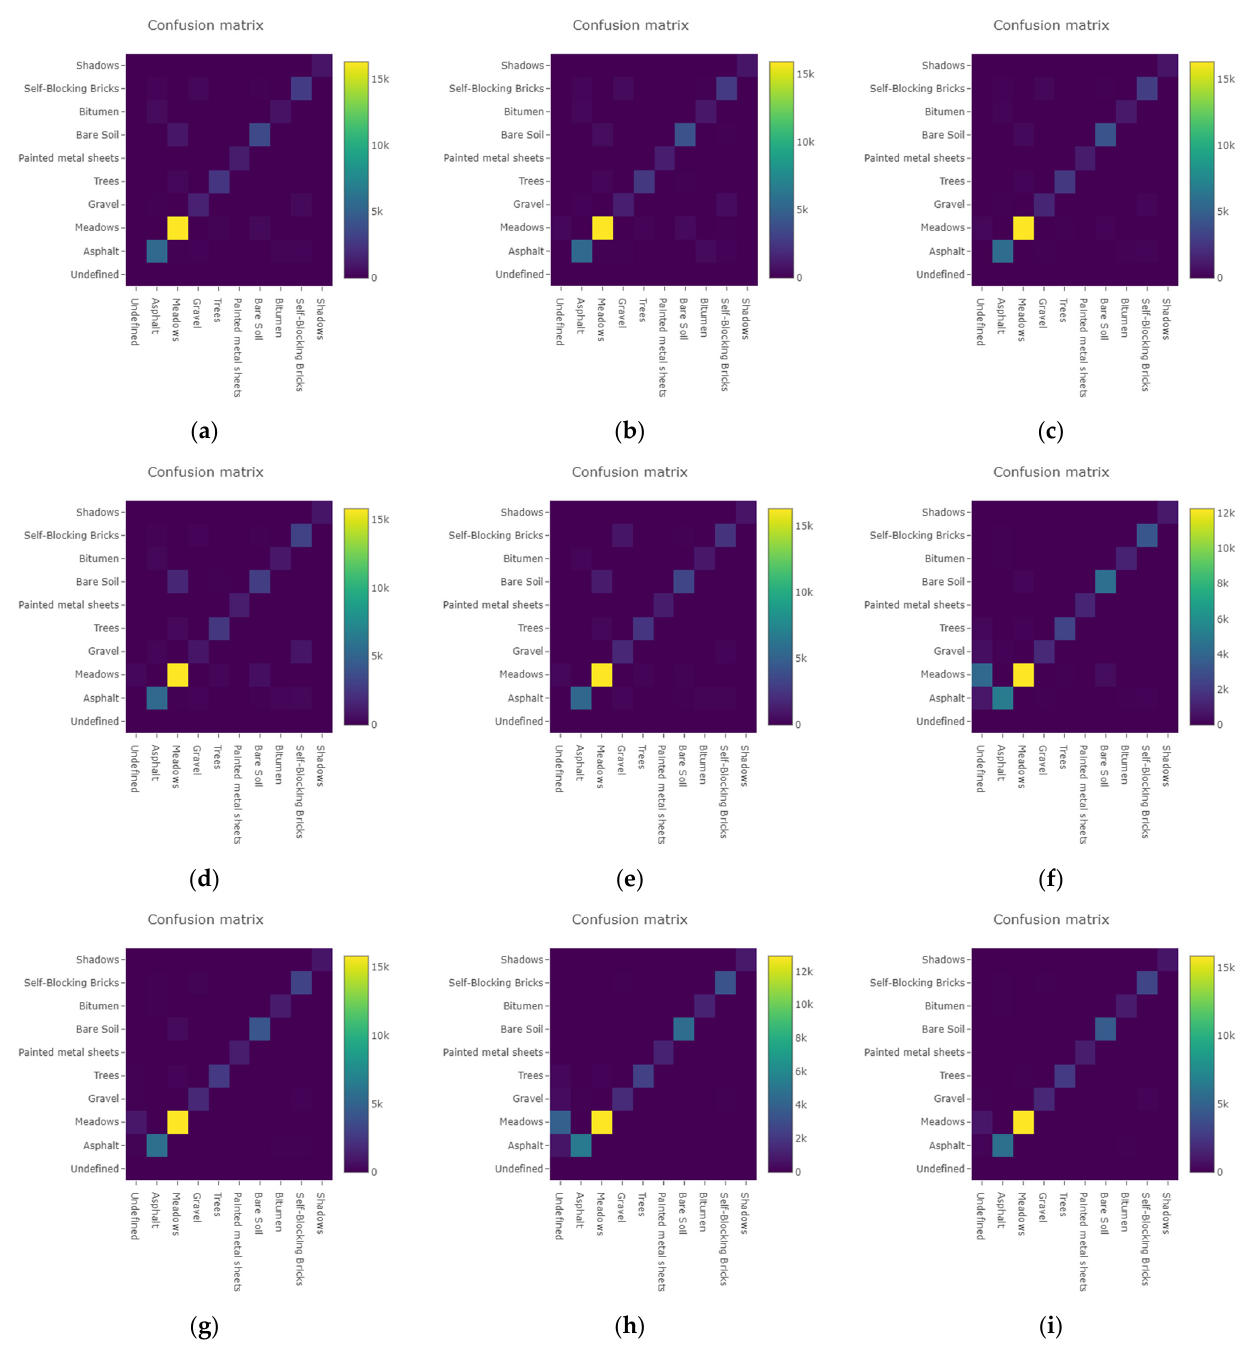
Figure 15. Confusion matrixes of the nine models on the Pavia University dataset. ( a ) SVM. ( b ) RNN. ( c ) ANN. ( d ) 1D CNN. ( e ) SF. ( f ) 3D CNN. ( g ) Hamida. ( h ) HybridSN. ( i ) ESFNet.